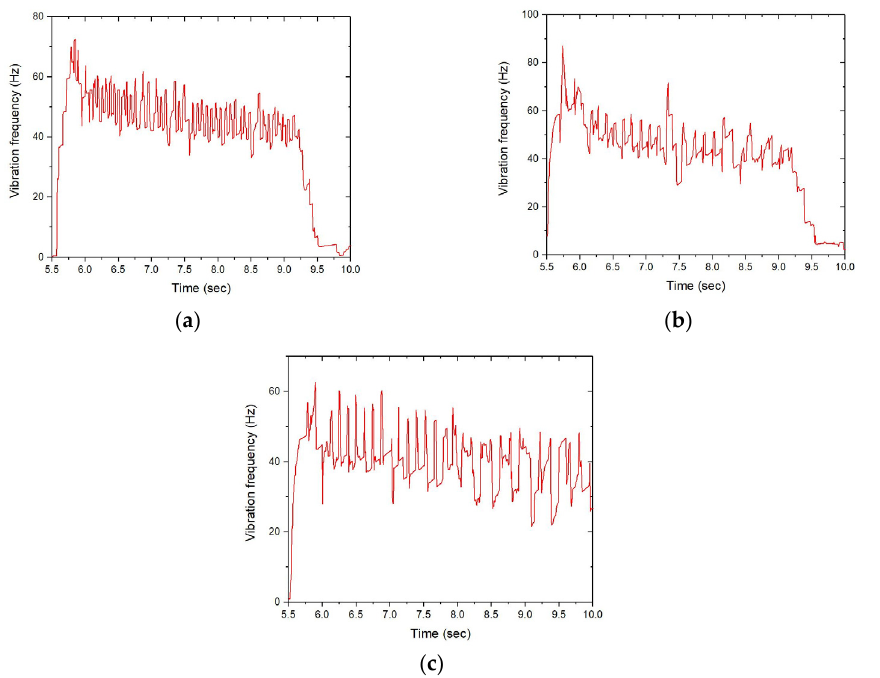
Figure 21. The vibration frequency of the robot with di ff erent turning radii: ( a ) 400 mm robot vibration frequency; ( b ) 500 mm robot vibration frequency; ( c ) 600 mm robot vibration frequency.